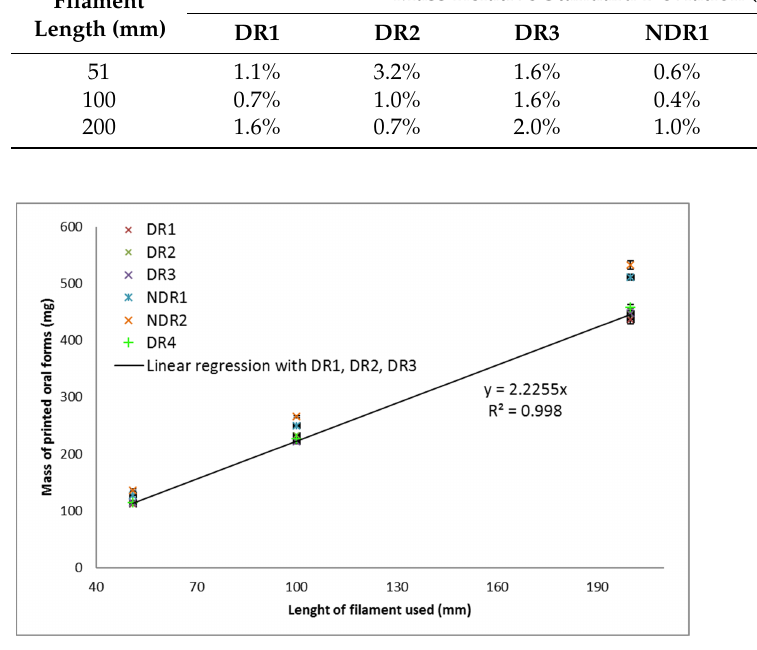
Figure 13. Oral form weights as a function of the filament quantity used by the 3D-printing pro- cess ( top ) and corresponding mass RSD ( bottom ).